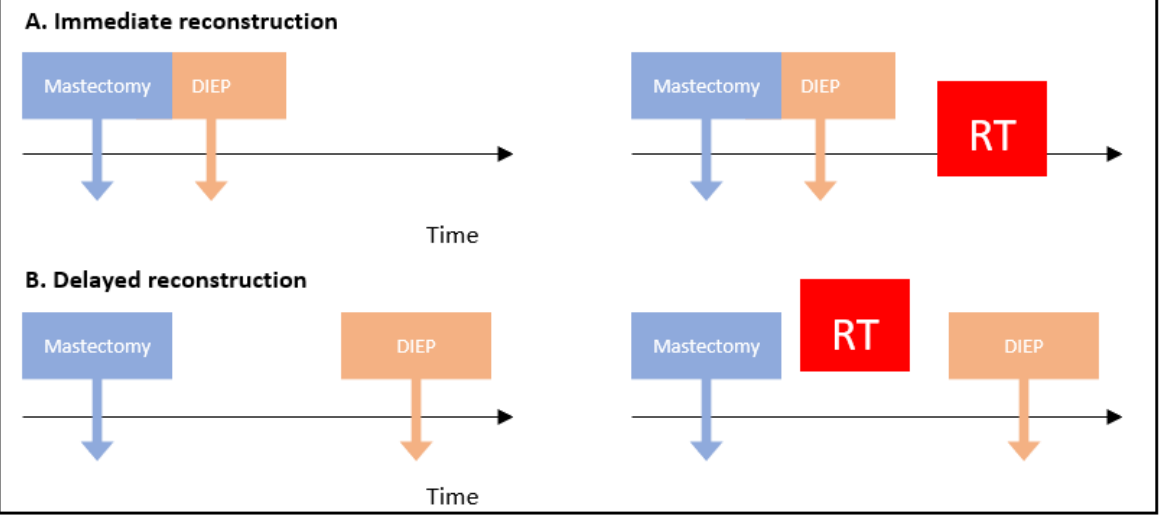
Figure 1. Time options for breast reconstruction. RT = radiotherapy; DIEP = deep inferior epigastric perforator flap.